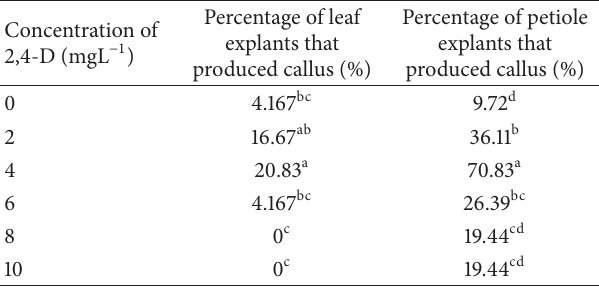
Table 1: Effects of different concentrations of 2,4-D on the percent- age of callus induction between leaf explants and petiole